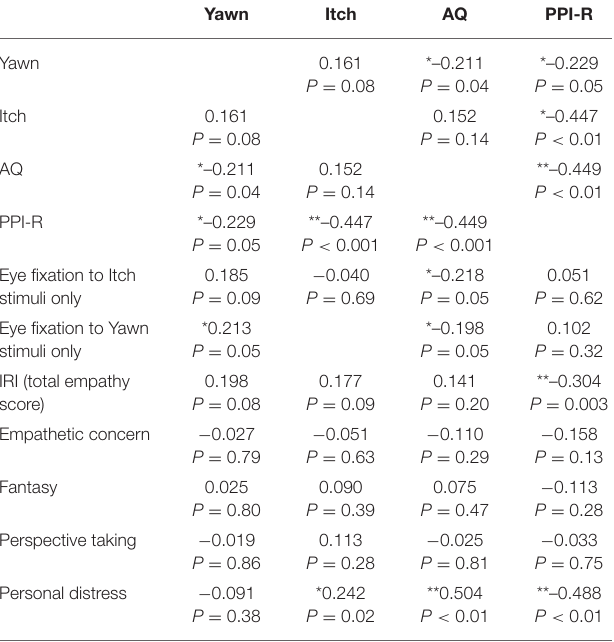
TABLE 2 | Correlation matrix using spearman